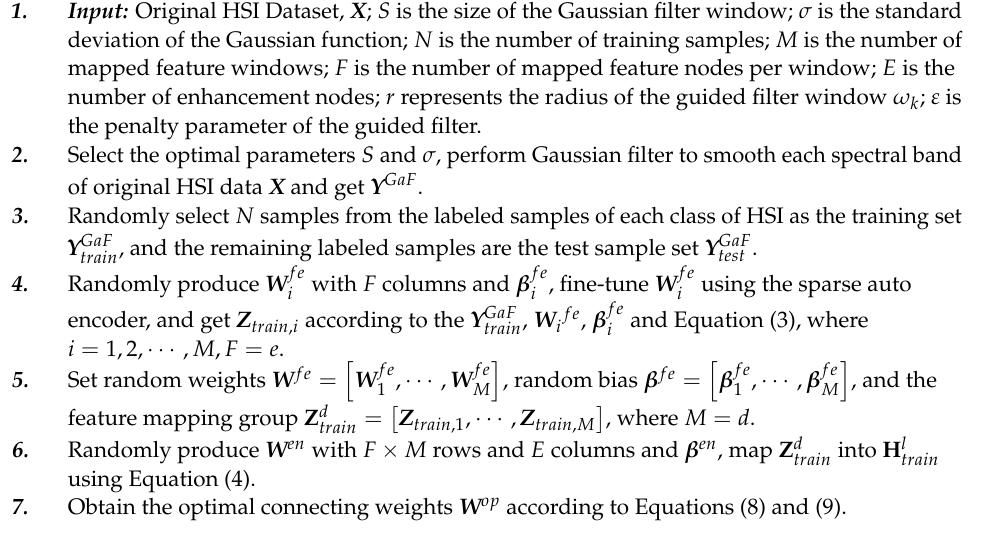
Algorithm 1. Algorithmic details of